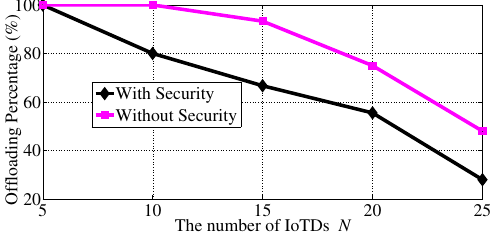
Figure 3. The offloading percentage of IoTD